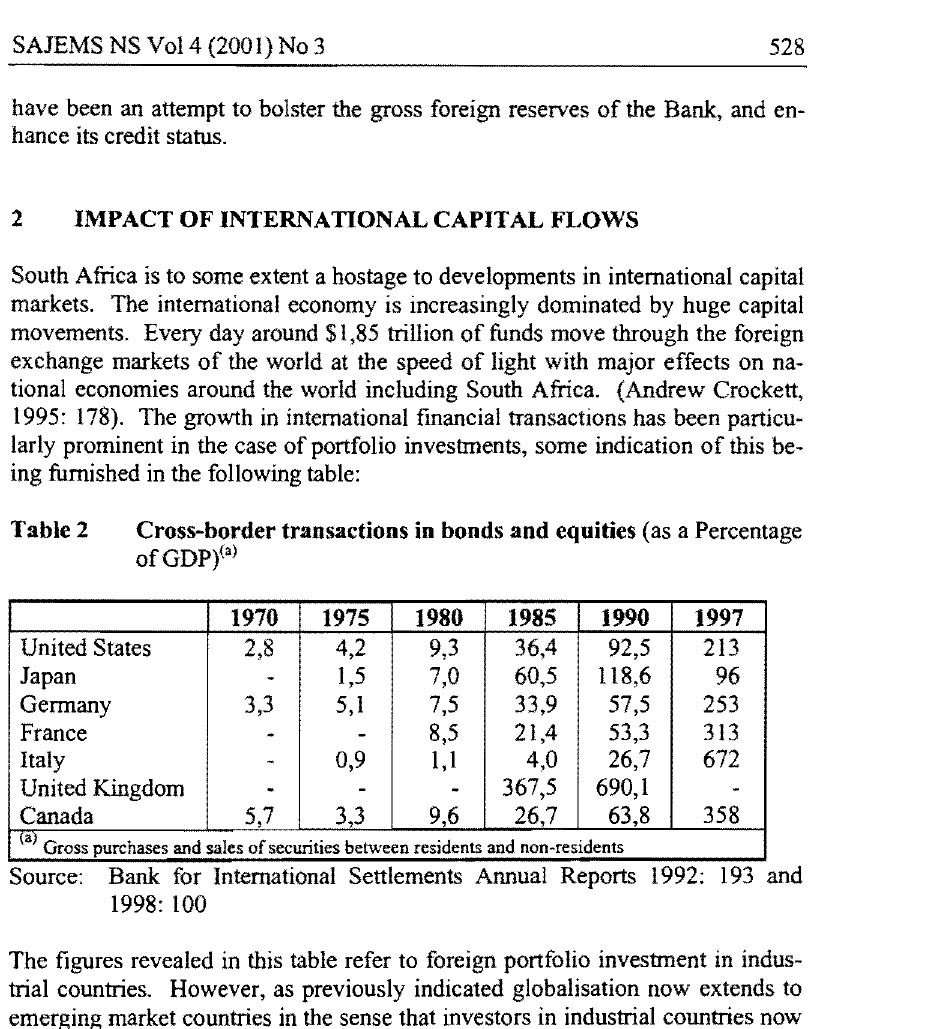
Cross-border transactions in bonds and equities (as a Percentage ofGDP)(a)